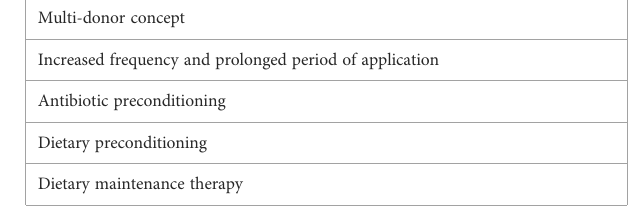
TABLE 1 Strategies to increase the ef fi cacy of FMT in